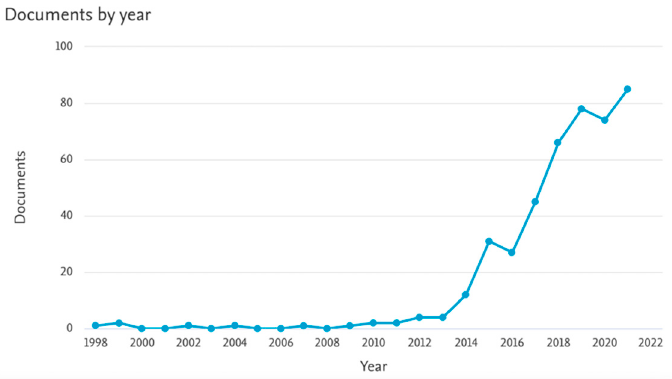
Figure 2. Analyze search results by keywords: ‘multi-material printing’ in 2000–2021 [64].